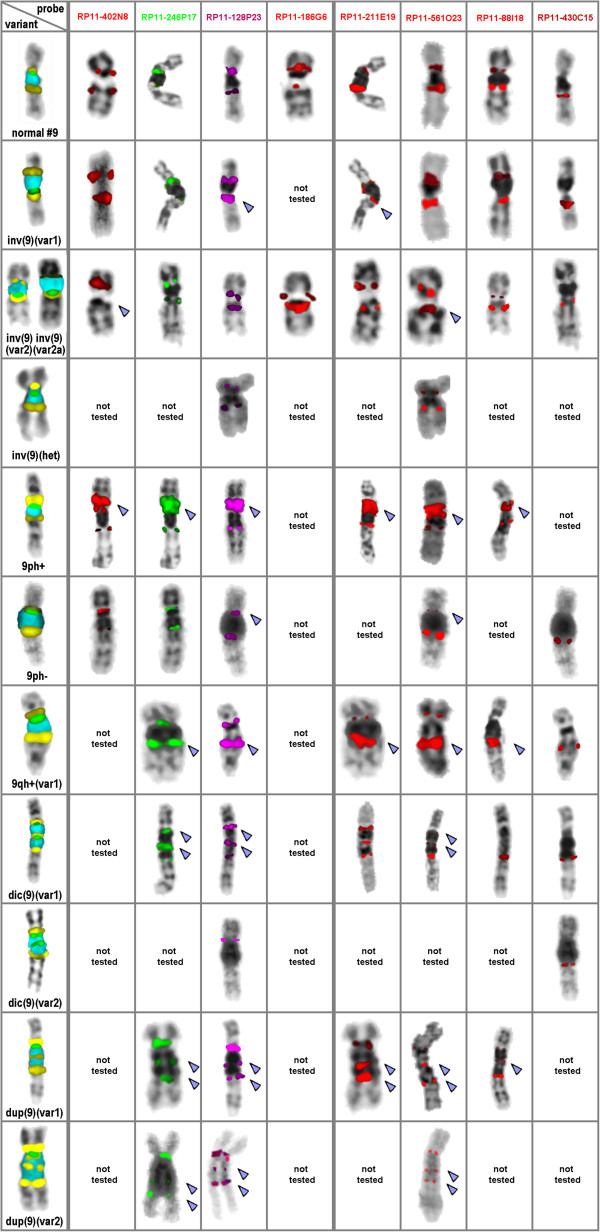
Obtained hybridization patterns observed after application of the 8 locus-specific probes mentioned in the first row of the depiction in 11 of the 17 heteromorphic patterns of Figure 1. Results for variants 9qh+ and 9qh- are not presented as they were similar as for the normal variant (normal #9). Breakpoints for inversions, amplification signals or duplications are highlighted by arrowheads.